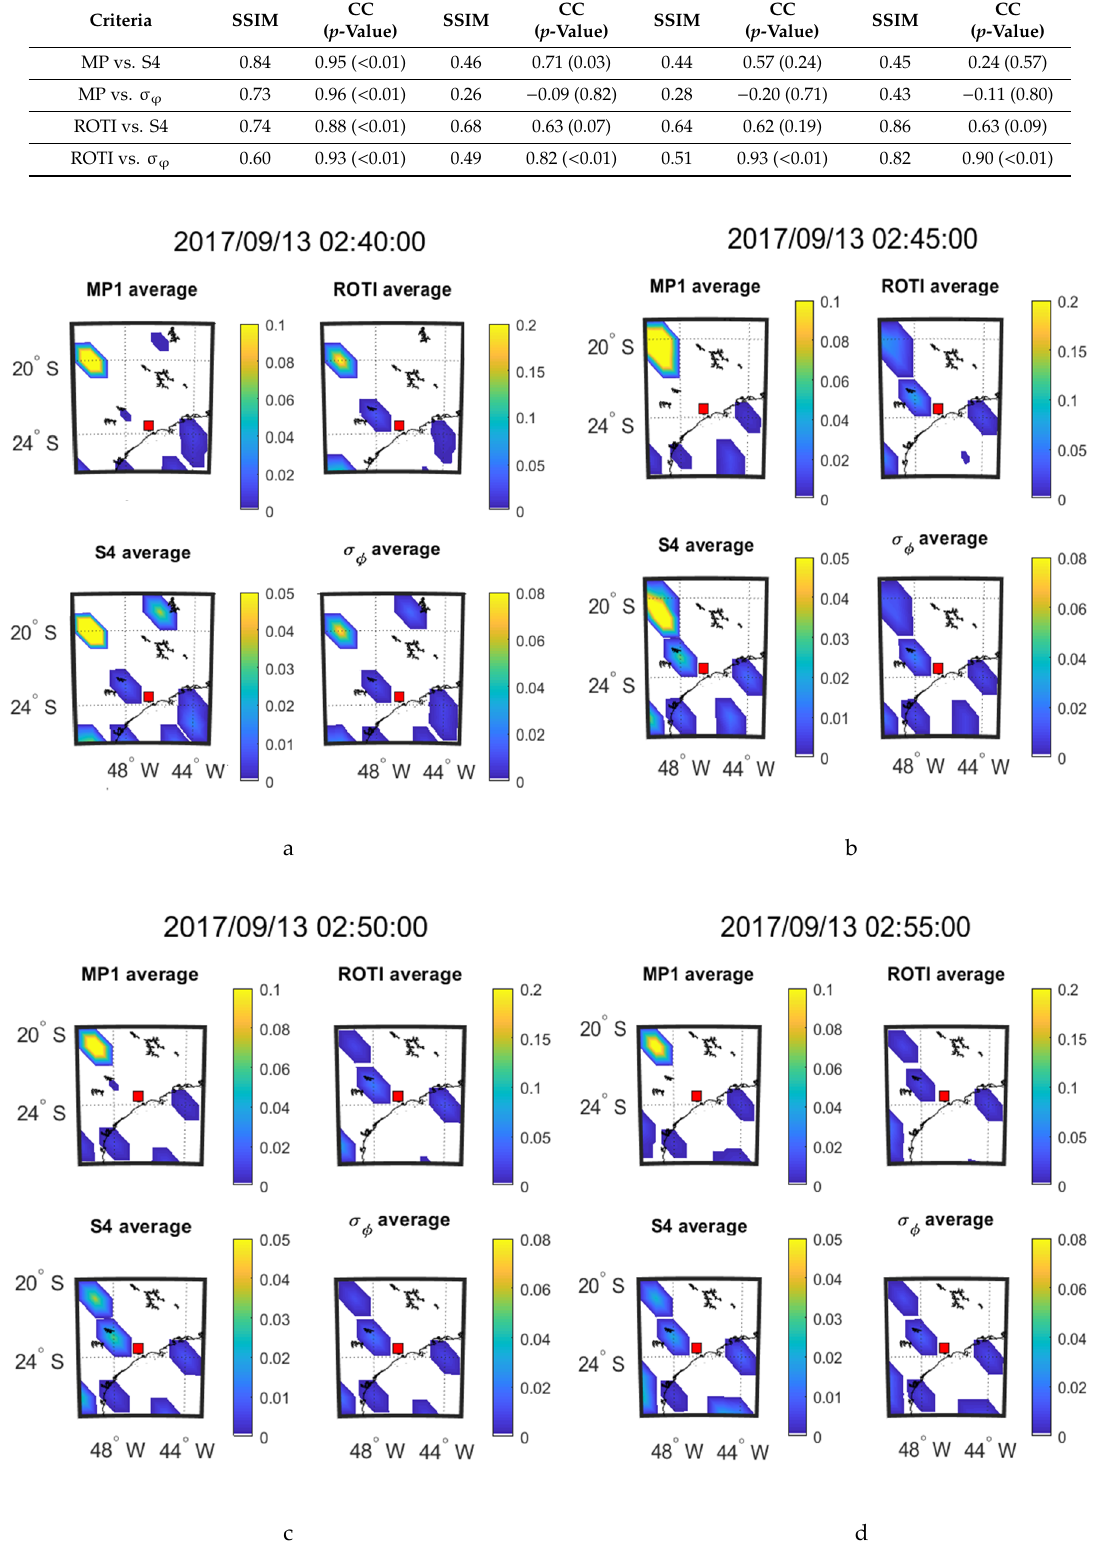
Figure 10. Consecutive 5 min means over 20 min at SAO0P station on 13 September Figure 10. xxxxxxxxx